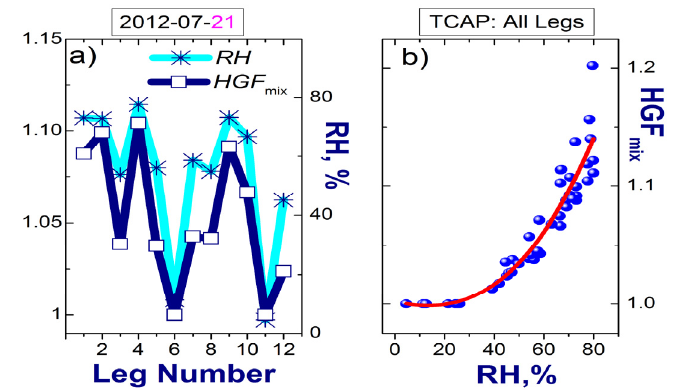
Figure 5. Example of ambient RH and RH-dependent HGF mix calculated for each FL during a given day (21 July 2012) ( a ); scatterplot of RH-dependent HGF mix (blue dots) for all TCAP FLs used in this study (Section 3) with polynomial fit (red line) ( b